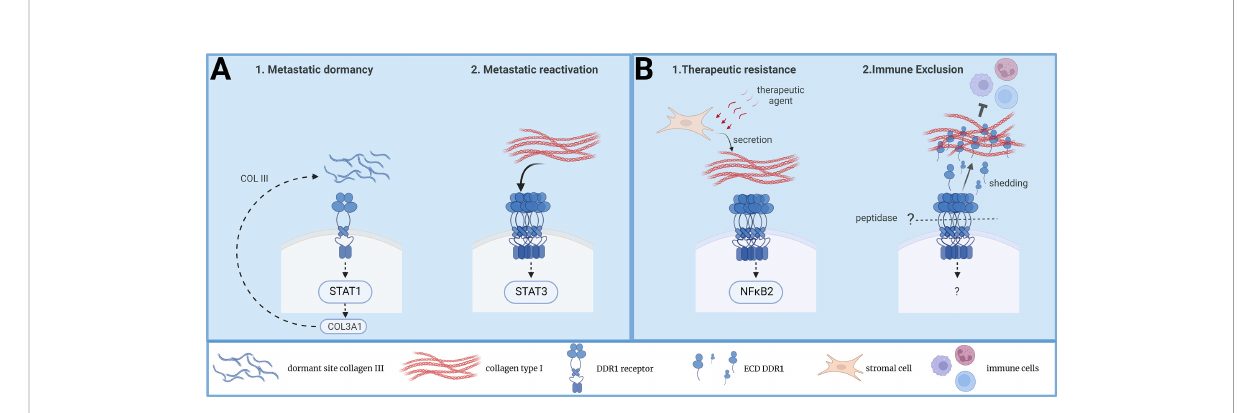
FIGURE 1 New functions of DDR1 collagen receptor in tumor dormancy, immune exclusion and therapeutic resistance. (A) A model on DDR1 signaling during DTC dormancy and metastatic reactivation induced by TME collagens . (B) A model on DDR1 signaling during therapeutic resistance and immune exclusion induced TME